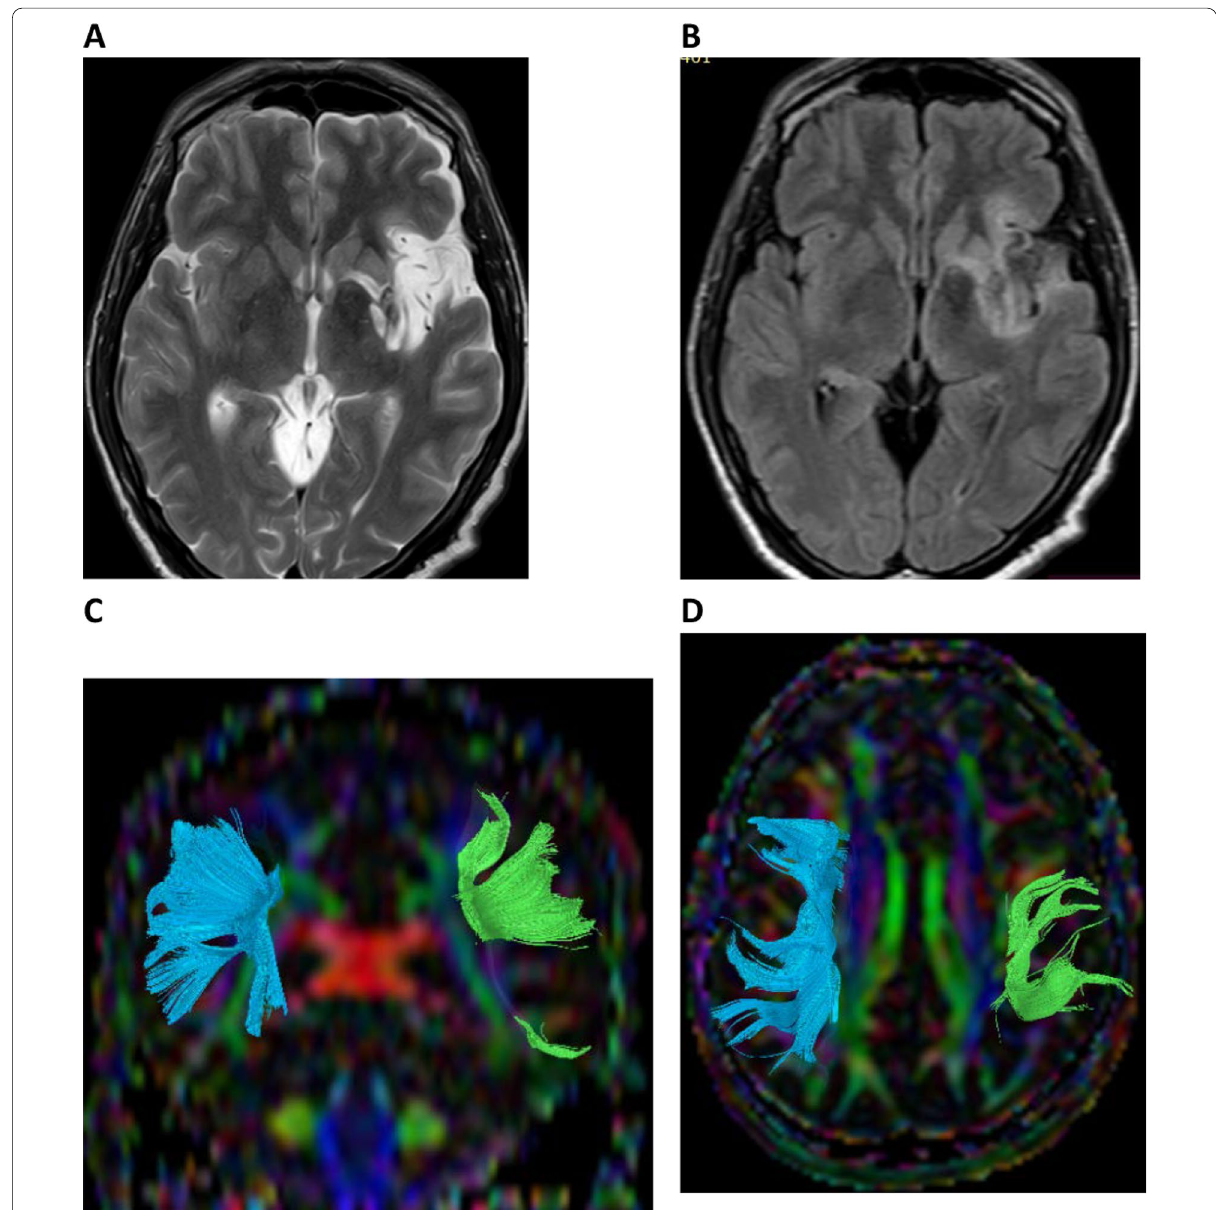
Fig. 2 DTI of patient with mild aphasia: 46‑year‑old male, a axial T2‑WI, b axial FLAIR image showing Lt. temporal infarction, c coronal DTI image with reconstructed AF, d axial DTI image with reconstructed SLF showing mild reduction of the Lt. AF and Lt. SLF size with decreased number of fibers. On the Rt. side values showed more preserved function and